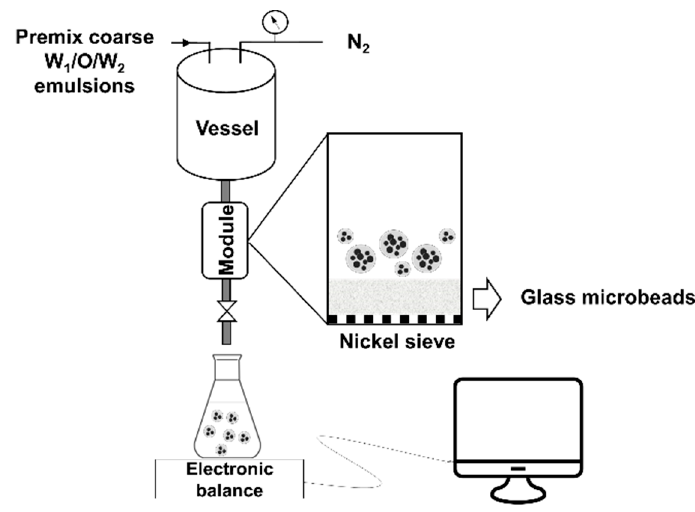
Figure 1. Schematic representation of experimental DMTS